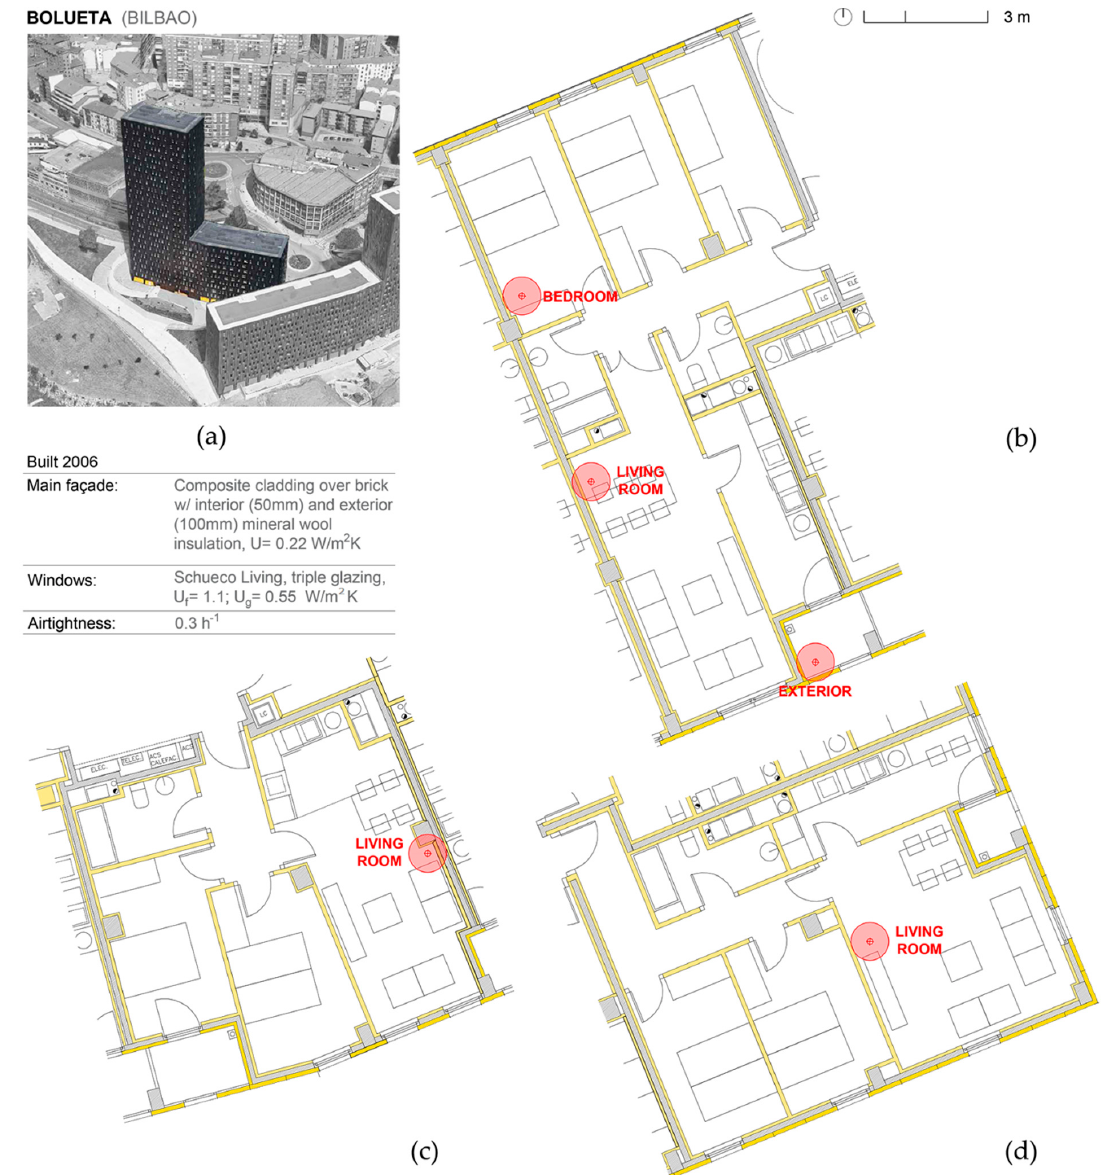
Figure 5. ( a ) Aerial perspective of Bolueta Tower 1. Source: Google Maps. ( b ) Floorplan of the monitored flat Bolueta Low. Drawing ( c ) corresponds to Bolueta Medium and ( d ) to Bolueta High. Note the indicators of datalogger positioning. Source: authors based on as-built documentation.